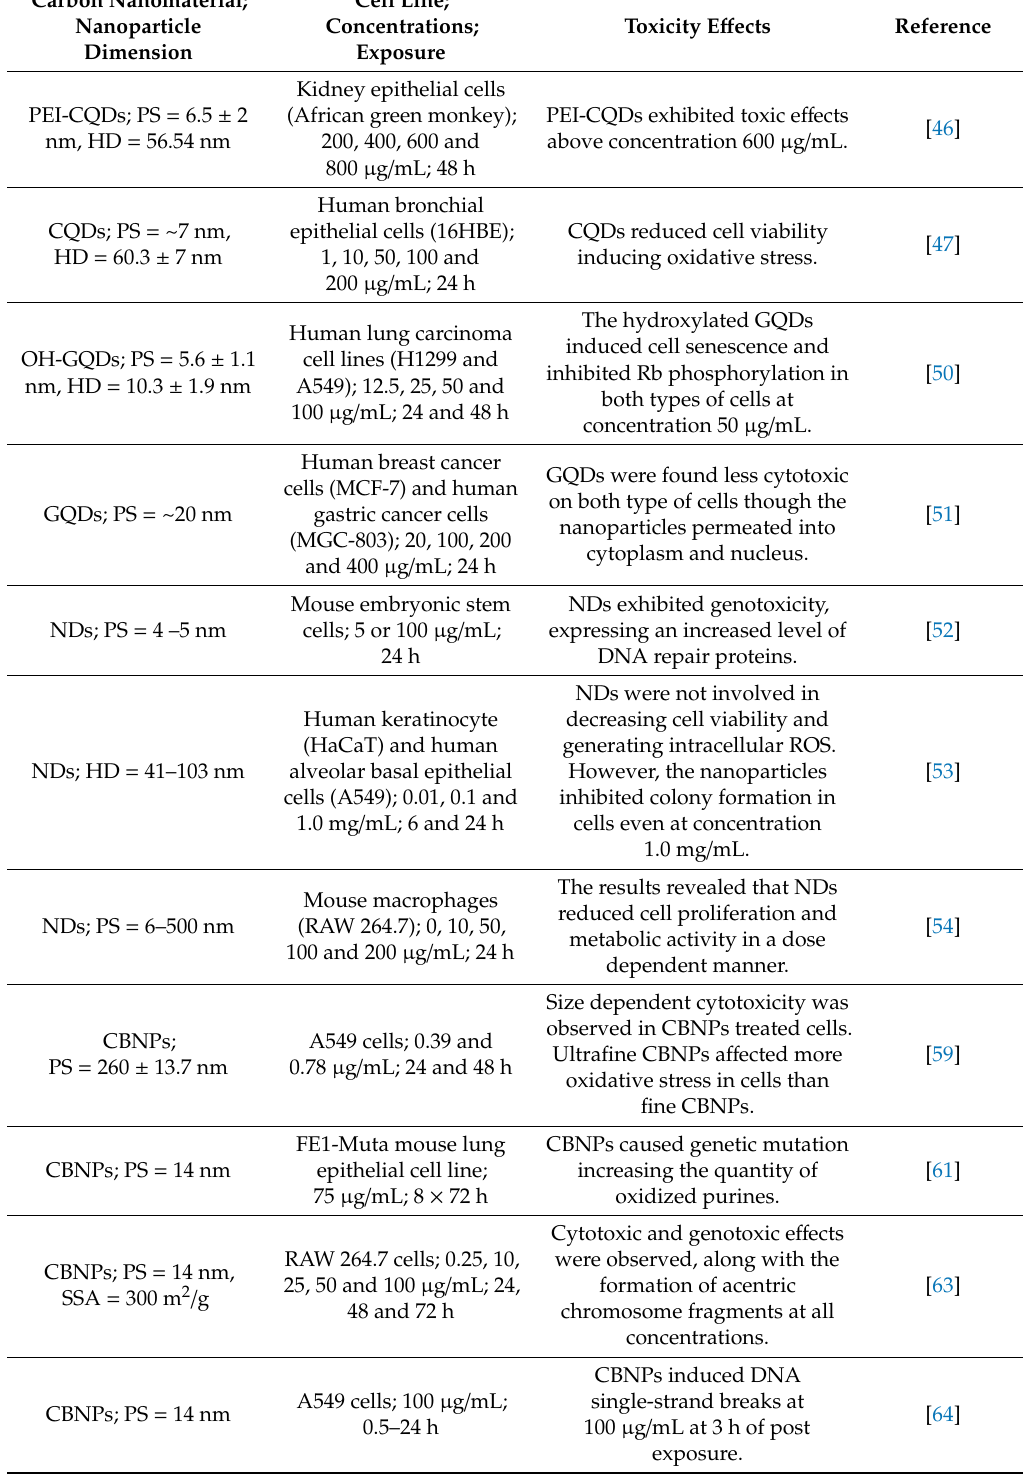
Table 1. The in Vitro Toxicity E ff ects of 0-D and 1-D Carbon Nanomaterials. Carbon Nanomaterial; Nanoparticle